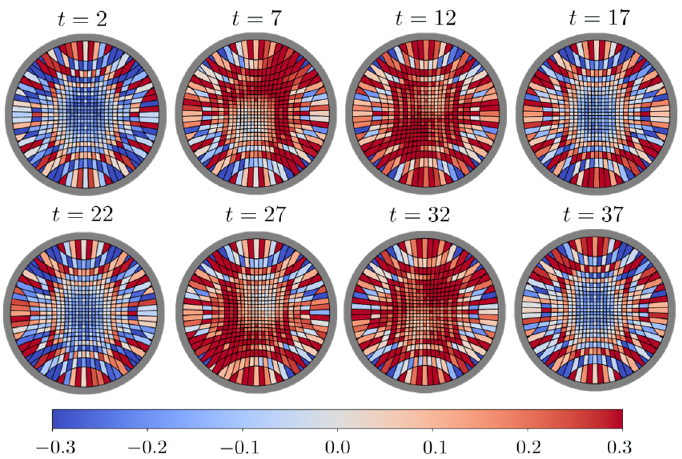
Figure 7. Quenched time dynamics of the reconstructed geometry corresponding to a mass defor- mation at two distinct sites ( S = { 0 , 30 } ). The trace of h ij is shown here. The boundary relative error is E bdy ≈ 0 . 41